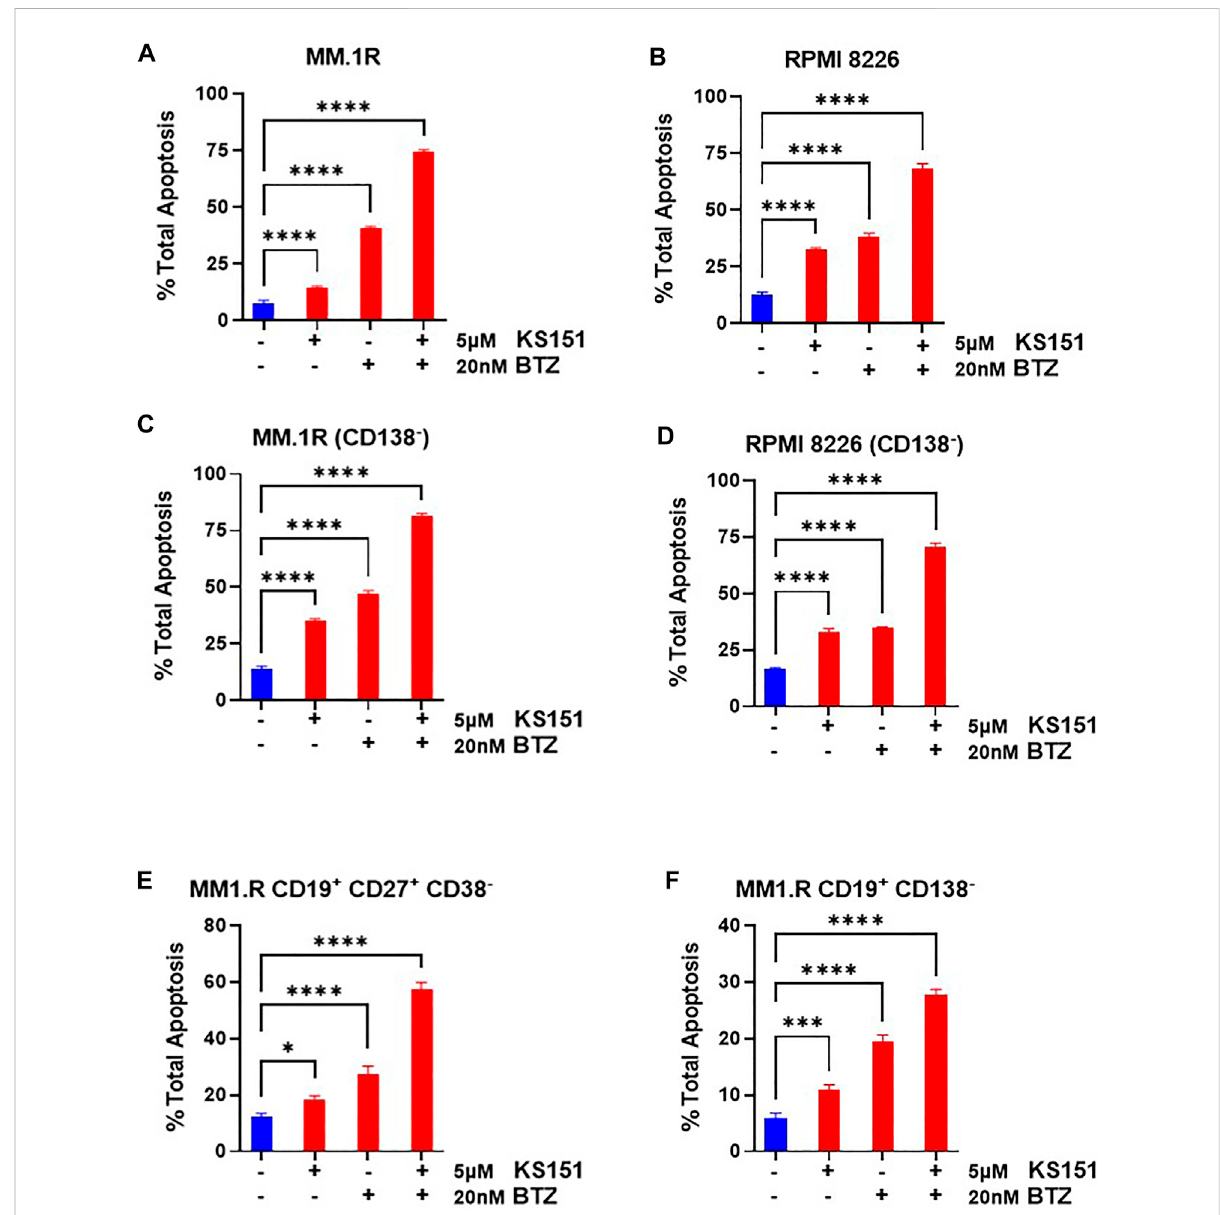
FIGURE 6 Combination studies of KS151 with bortezomib. (A-B) , Annexin V staining to detect either MM.1R or RPMI 8226 apoptotic cells. MM.1R or RPMI 8226 cells were treated with 5 μ M of KS151 alone or in combination with 20 nM bortezomib. After 24h, cells were stained with Annexin V dye and analyzed by the Muse Cell Analyzer by a method described in the materials and methods section. (C-D) , Annexin V staining to detect CD138 − MM.1R and CD138 − RPMI 8226 apoptotic cells. After sorting CD138 − cells from MM.1R or RPMI 8226 with Bio-Rad cell sorter, cells were kept in the incubator overnight to recover and then treated with 5 μ M of KS151 alone or in combination with 20 nM bortezomib. After 24 h, cells were stained withAnnexinV dyeand analyzedby MuseCell Analyzer. (E-F) ,Annexin V stainingto detect CD19 + CD27 + CD 38 − MM.1R andCD19 + CD138 − apoptotic cells. After sorting CD19 + CD27 + CD38 − or CD19 + CD138 − cells from MM.R with Bio-Rad cell sorter, cells were kept in the incubator overnight to recover and then treated with 5 μ M of KS151 alone or in combination with 20 nM bortezomib. After 24h, cells were stained with Annexin V dye and analyzed by Muse Cell Analyze. One-way ANOVA was used to determine statistical signi fi cance. Each data point is the average of three replicates. * p ≤ 0.05, ** p ≤ 0.04, *** p ≤ 0.0001, **** p ≤ 0.0001 signi fi